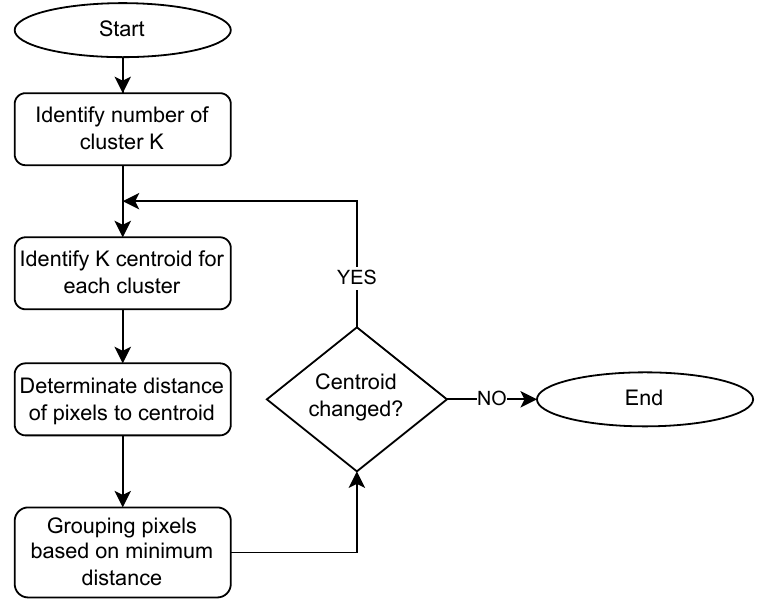
Figure 13. k-means